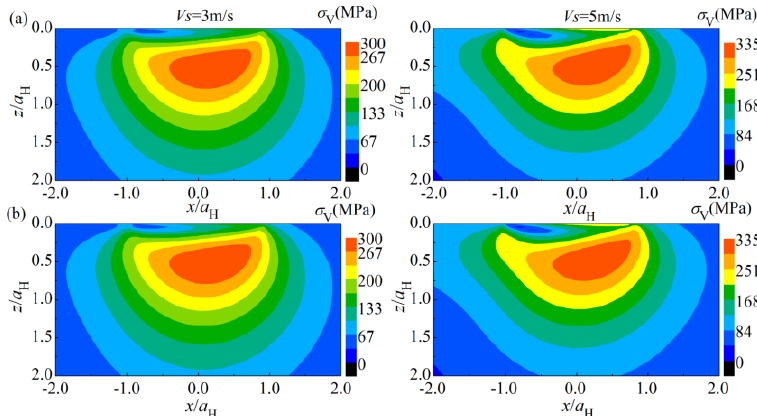
Figure 6. Comparison on the von Mises stress in xoz plane between the present model and Chen’s model under different sliding speeds: ( a ) solution of Chen’s model, ( b ) solution of the present model.